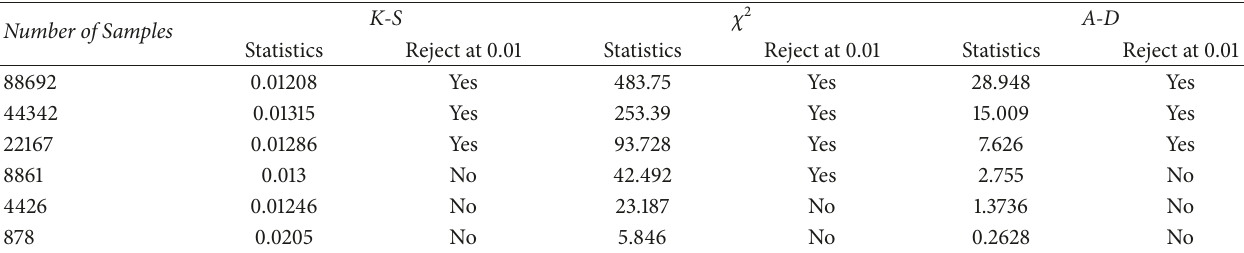
Table 5: Effect of number of samples in the goodness-of-fit test decision—all drivers—speed interval [90, 108[ ). K-S 𝜒 2 Number of Samples